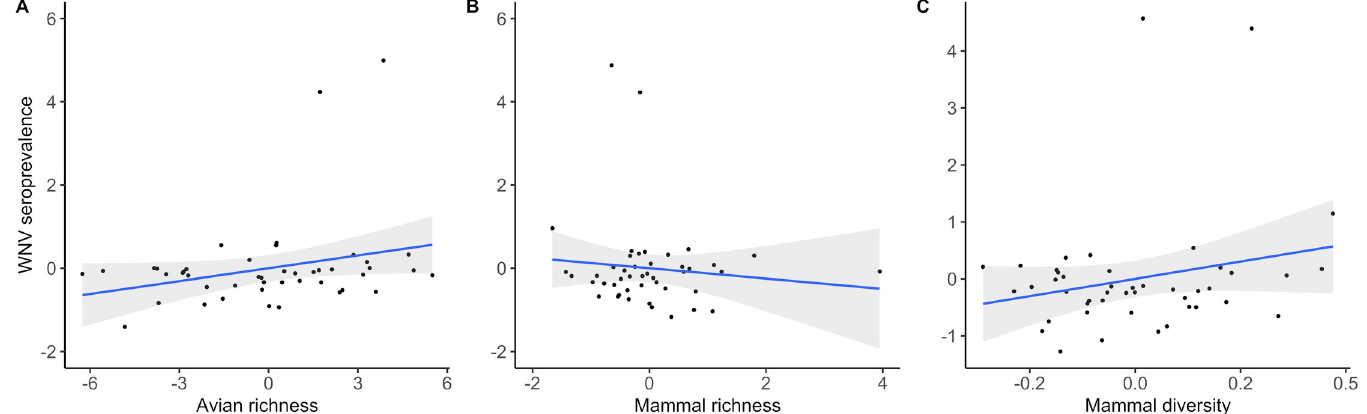
Fig 1. Leverage plots showing the relationships between WNV seroprevalence in house sparrows from the 45 localities included in this study and A) avian richness (estimated from a rarefaction curve), B) mammal richness (estimated from a rarefaction curve), and C) mammal diversity (measured as the evenness index). The prevalence of Leucocytozoon was calculated using the least squares means of a GLM controlling for birds’ ages and locality. The 95% confidence level interval is shown in grey.